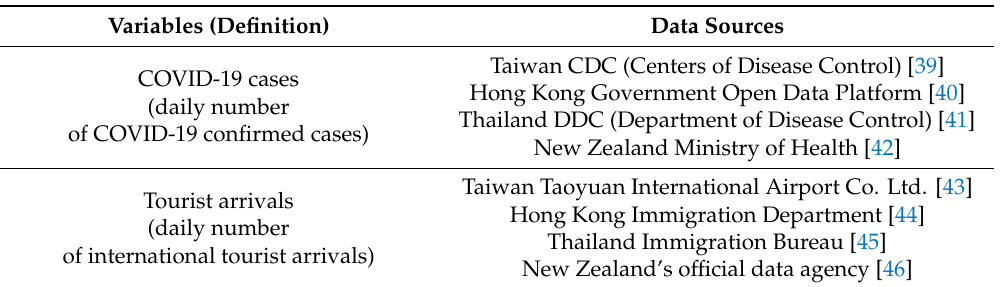
Table 1. Summary of data sources.